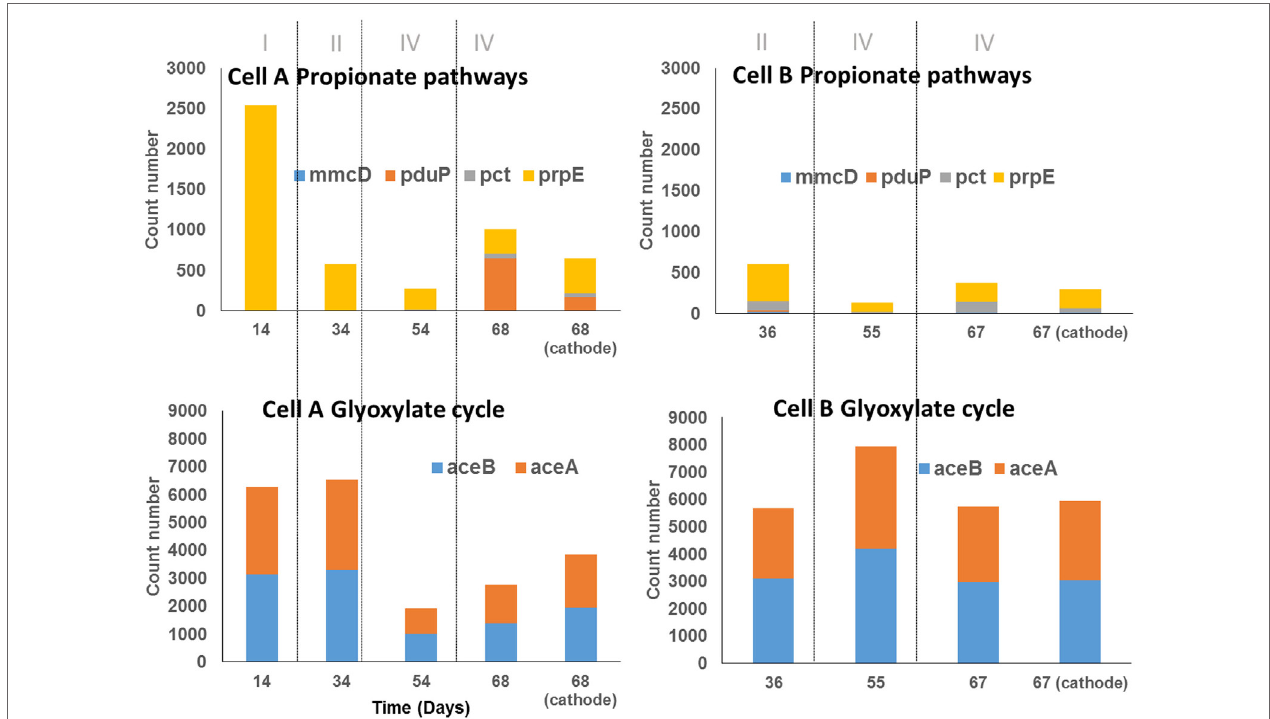
FigUre 5 | Abundance of genes encoding key enzymes for propionate production and short-chain fatty acid uptake (glyoxylate cycle) in samples of cells A and B according to PICRUSt analysis. The samples taken from the biomass in the bulk solution are indicated by the day of sampling, the sample taken from the biocathodes at the end of the experiment were indicate as the day of sampling and the word cathode. The count number was calculated as the sum of the number of reads that are assigned to the specie that contains the particular gene, divided by the number of copies of the gene encoding the 16S rRNA reported for the specie to which read was assigned and multiplied by the gene replicates number in the annotated genome of the closest